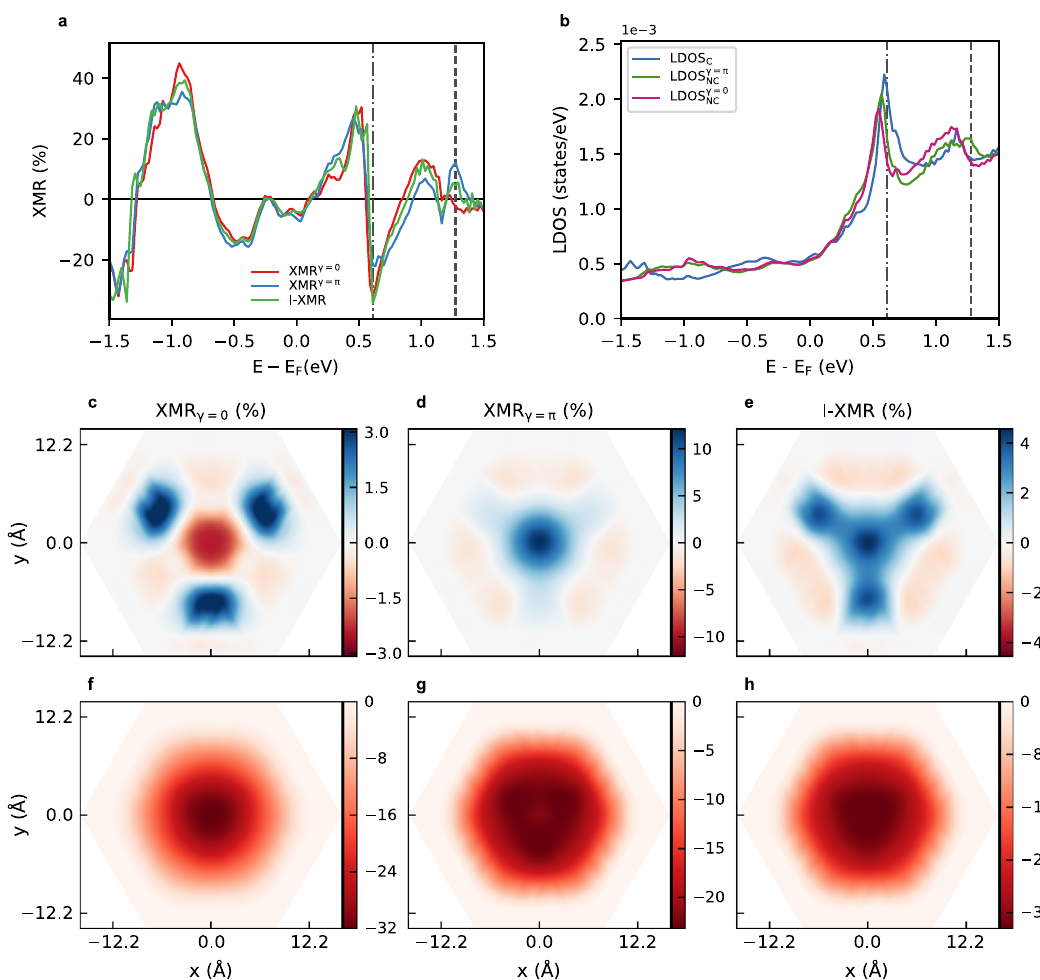
Fig. 2 Impact of the helicity on the XMR signal. a Comparison of energy-resolved XMR signals with different helicities and without SOC measured on top of the skyrmion ’ s core. b Sum of spin-resolved electronic structure in the vacuum on top of the core of a Neéel-type skyrmion with diameter D sk ≈ 2.2 nm for different helicities and above the collinear con fi guration. The dashed and doted-dahed lines indicate, respectively, the tunneling energies eV = 1.27 eV and 0.61 eV at which a spatial map of the whole skyrmion is plotted for c , f XMR γ = 0 , d , g XMR γ = π and e , h I-XMR bias